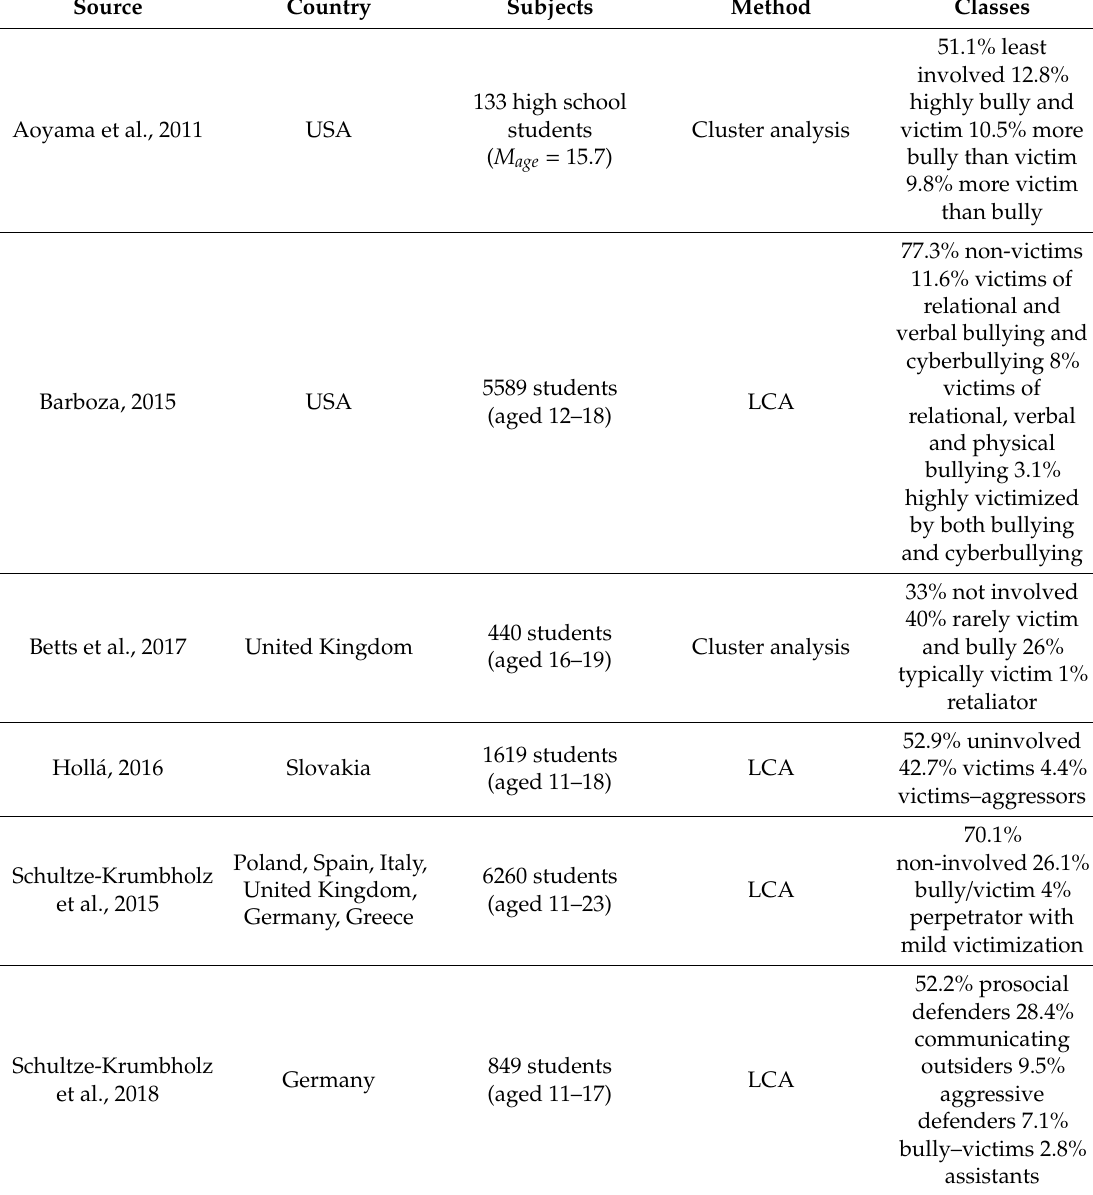
Table 1. Summary of the studies